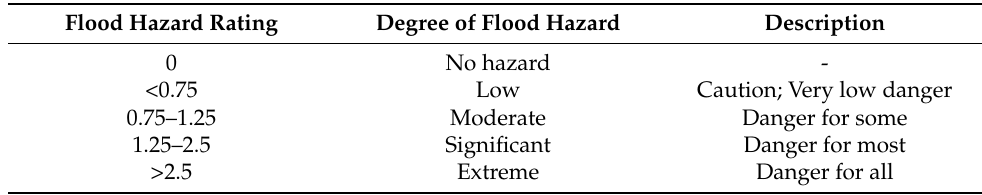
Table 1. Flood hazard classes [22].